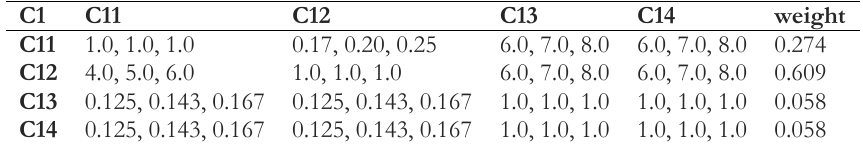
Table 3. The fuzzy comparison matrix of the subcriteria in regard to main criterion C1.*